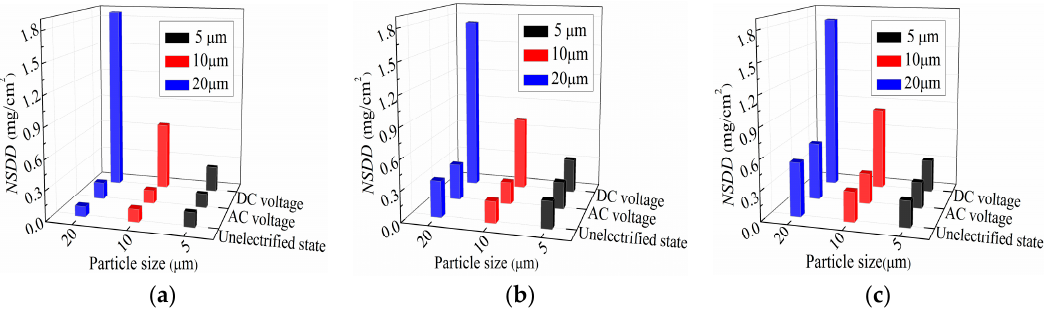
Figure 7. NSDD of the porcelain bell jar insulator, ( a ) v = 3 m/s; ( b ) v = 5 m/s; and ( c ) v = 7 m/s.